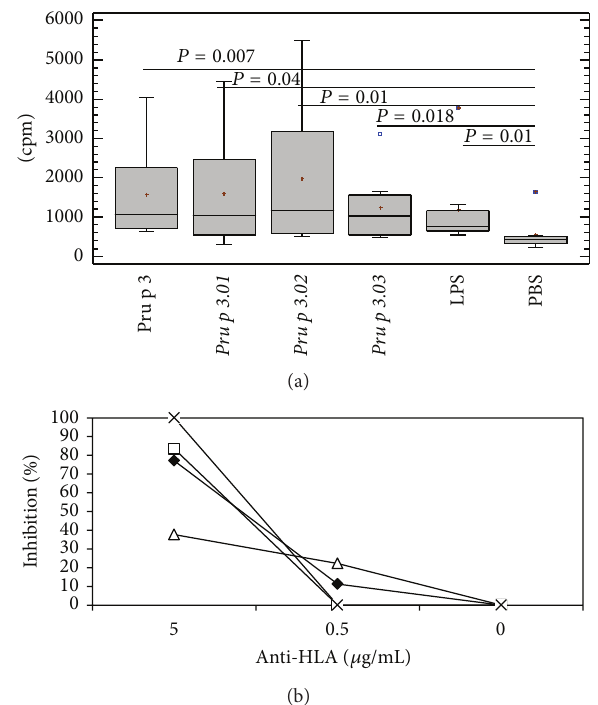
Figure 4: (a) Proliferative response of Pru p 3 T cell lines from peach-allergic patients to wild type, mutants ( Pru p 3.01, Pru p 3.02 , and Pru p 3.03 ), LPS, and negative control (PBS), as a measure of incorporated radioactivity. Medians (—) and range (bars) were calculated from 𝑛 = 24 values for each protein. Significant differences between the antigens and untreated culture (PBS) are indicated. (b) HLA-II restriction specificity of T cell recognition of wild type and the mutant forms. The inhibition percentage of the proliferation of specific TCLs to each protein in the presence of anti- HLA antibodies is represented for patient 2, as an